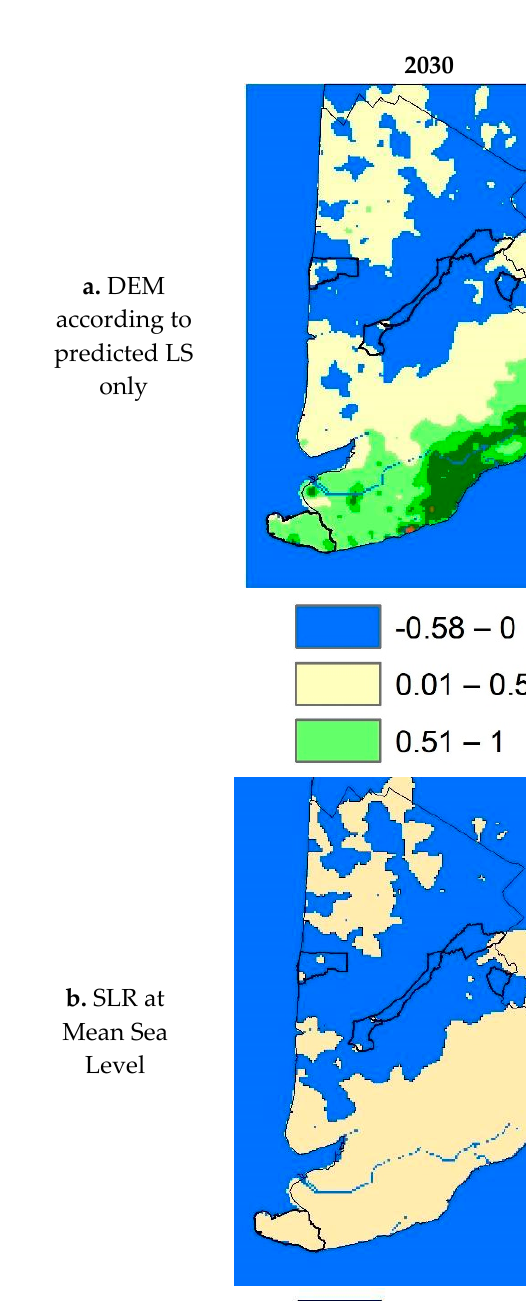
Table 3. Sample characteristics by commune. Commune